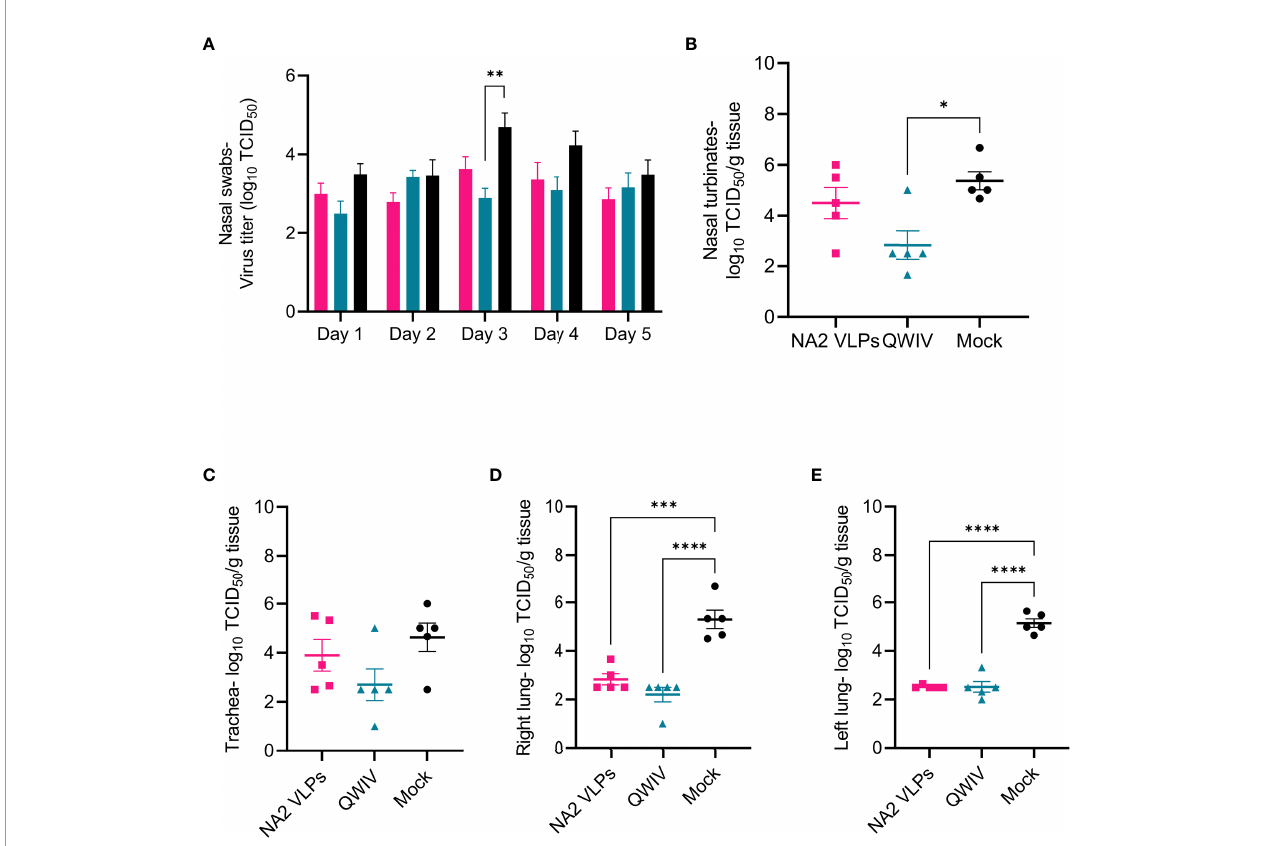
FIGURE 6 | Vaccination with NA2 VLPs and the commercially available swine QWIV vaccine reduces viral replication in pig lungs post-infection. Nasal swabs were collected from pigs daily post-challenge through necropsy on day 5 and virus titers were measured via TCID 50 assay. Tissue samples from the respiratory tract including nasal turbinates, trachea, right lung lobes including the accessory lung lobe, and left lung lobes were harvested 5 days post-infection at necropsy. Following tissue homogenization, virus replication was measured in each respiratory compartment via TCID 50 assay of tissue homogenates. (A) Viral titers from nasal swabs (B) Mean viral titers of homogenized nasal turbinates. (C) Mean viral titers of homogenized trachea tissue. (D) Mean viral titers of right lung lobe tissue homogenates. (E) Mean viral titers of left lung lobe tissue homogenates. Pink squares represent NA VLP vaccinated pigs, cyan triangles represent commercial QWIV immunized pigs, and black circles represent mock vaccinated pigs. Horizontal lines represent the mean for each group. Error bars represent SEM. Statistical analysis was performed by two-way ANOVA test (A) and one-way ANOVA test (B – E) . * = p < 0.05; **= p < 0.01; *** = p < 0.001; **** = p <